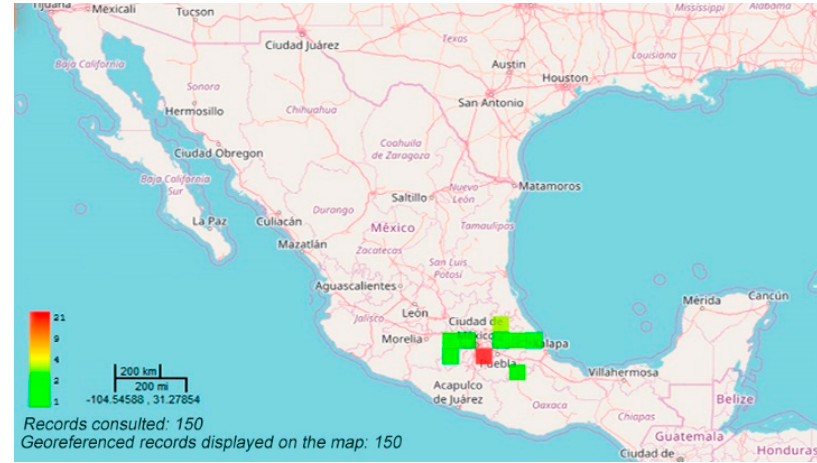
Figure 1. Distribution of Agastache mexicana in Mexico [7].